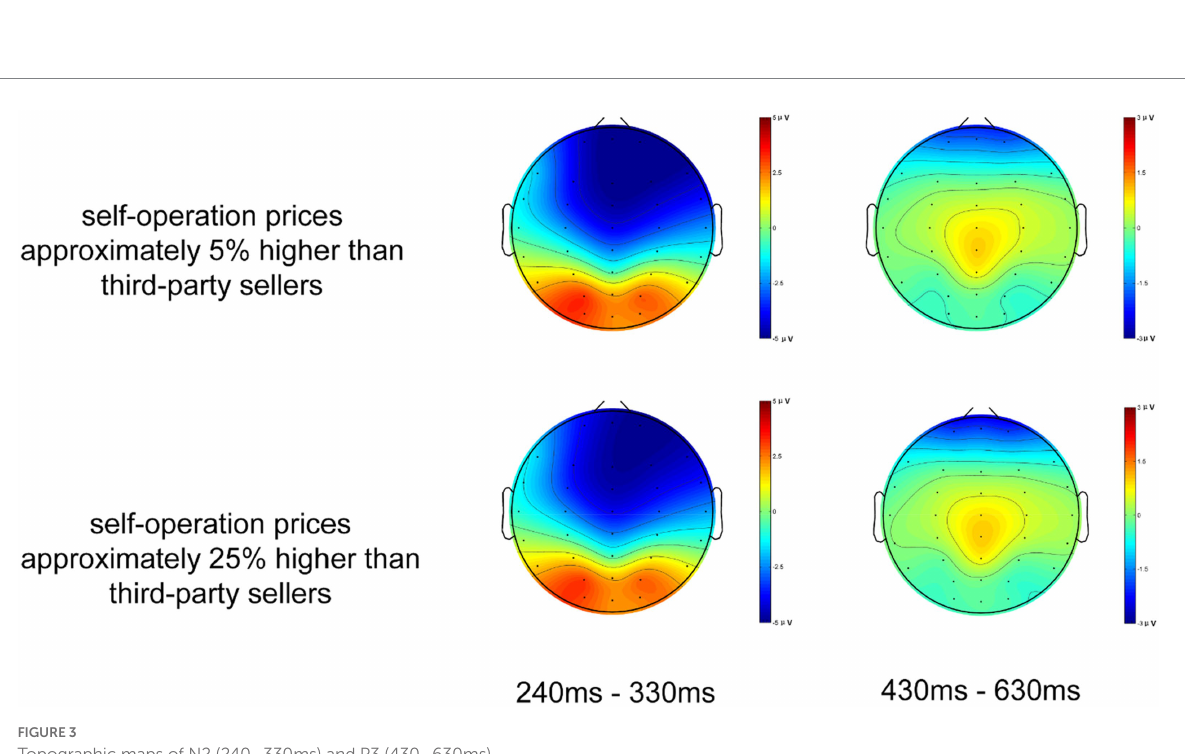
FIGURE 2 Raw ERPs waveforms at nine electrode